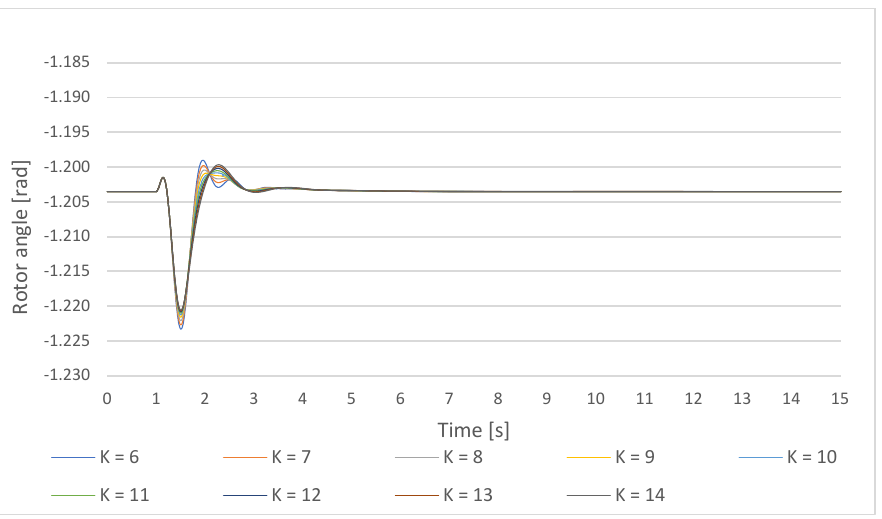
Figure 16. Gen1 rotor angle response on a small disturbance with PSS parameters T = 0.5 s, the PSS gain increase in the lower cluster 1- K i,ln = 6 – 10 and the upper cluster 1 K i,um = 10 – 14.